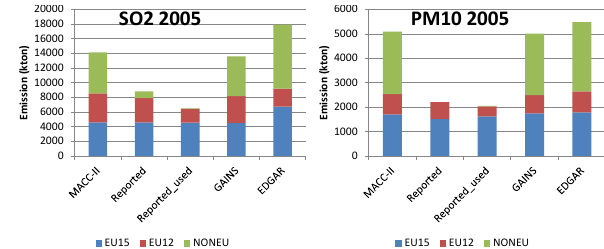
Figure 5. Comparison between the TNO_MACC-II results and the reported emission totals, reported emissions used in this study, GAINS and EDGAR v4.2 by country group, for SO 2 (left) and PM 10 (right).